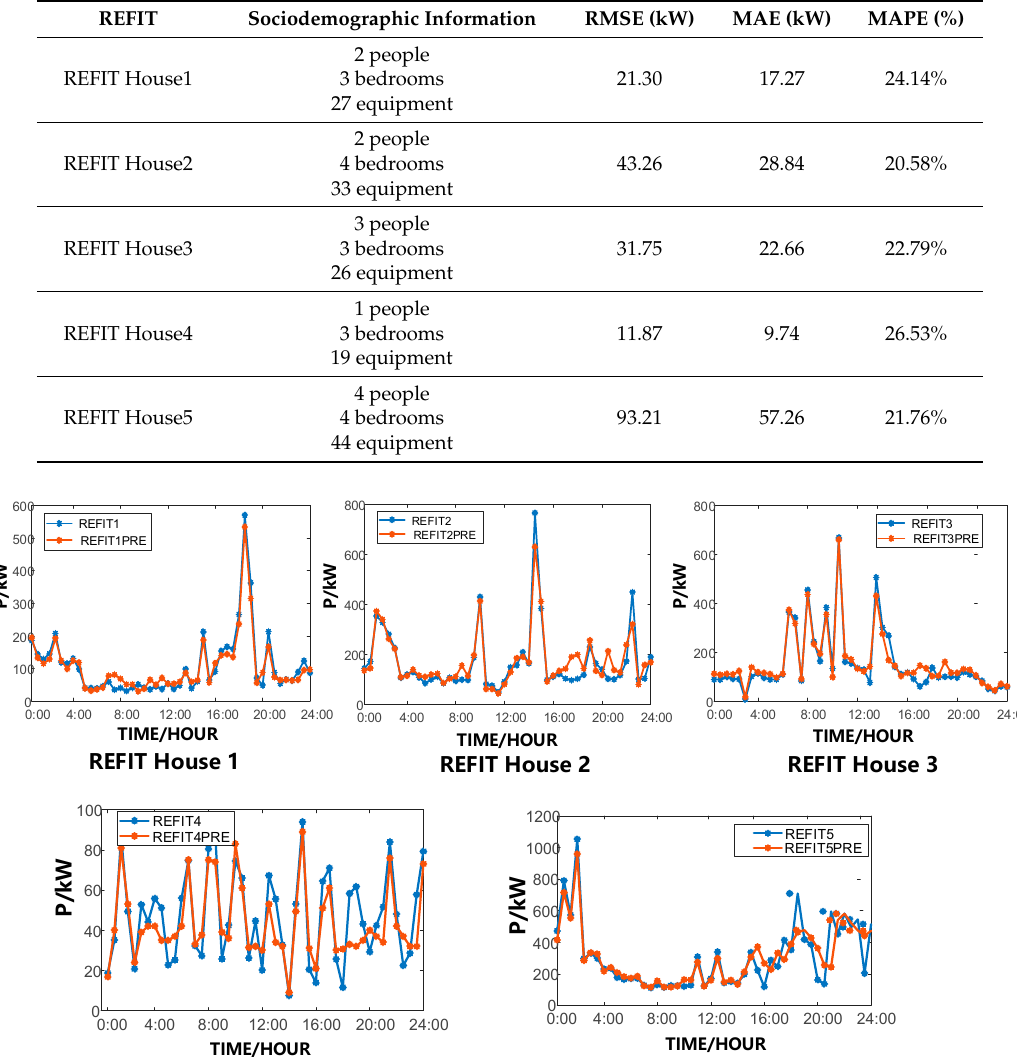
Table 3. Forecasting performance in five houses of REFIT using the proposed method.